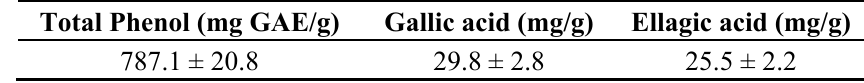
Table 1. Total phenols gallic and ellagic acid yield from T. chebula